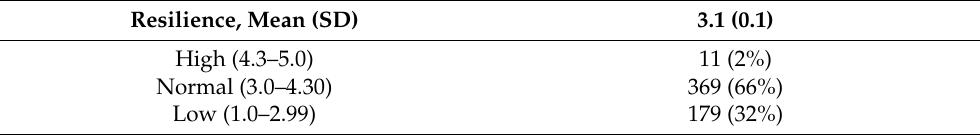
Table 3. Resilience level. Resilience, Mean